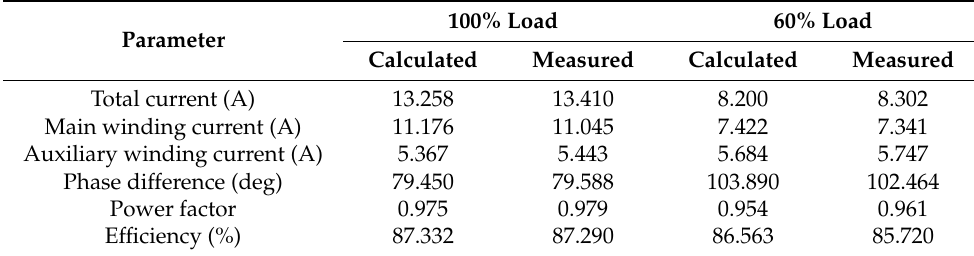
Table 2. Comparison of the calculated and measured results at 60% and 100% loading